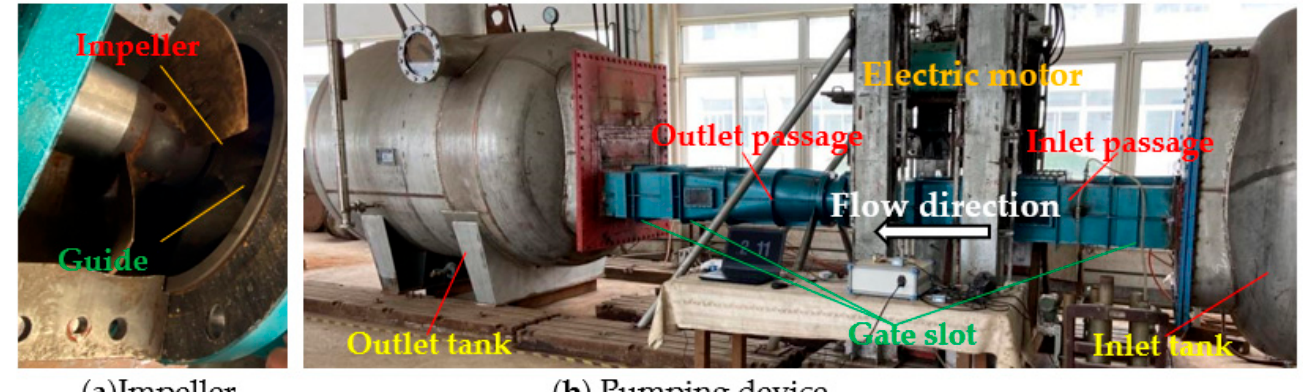
Figure 3. Pump and pumping device.